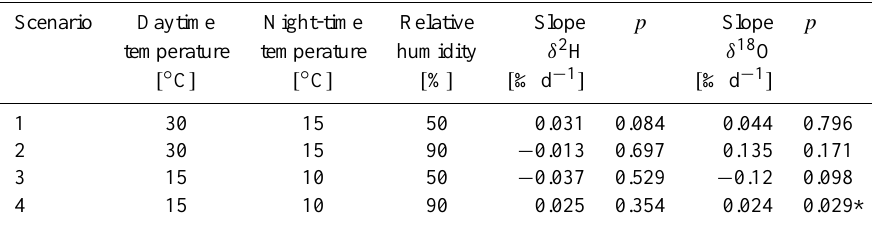
Table 1. Results of the validation experiment. Temperature and relative humidity during the validation experiment. Day- and night-time temperatures were programmed in 12-h cycles. Scenario Daytime Night-time Relative Slope p Slope p temperature temperature